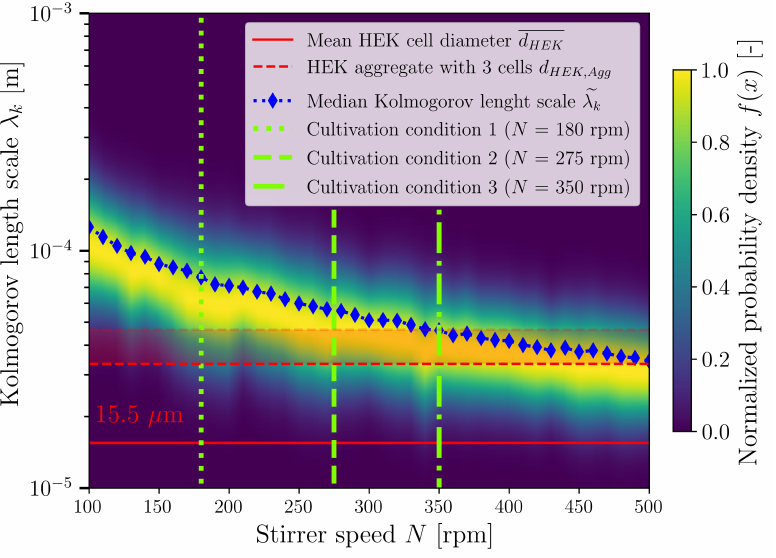
Figure 9. Normalised volume-related probability density function of the Kolmogorov length as a function of the stirrer speed. The respective median of the Kolmogorov lengths is shown as blue diamonds. The three stirrer speeds at which cultivation took place are shown in green as dotted (180rpm), dashed (275rpm), and dash-dot (350rpm) lines. The mean measured HEK293 cell diameter (15.5µm) is shown as a red line. The size of a three-HEK293 cell cluster is shown as an example with red dashed lines. The lowest value (33.4µm) corresponds to the close-packing and the highest value (46.5µm) to a cell